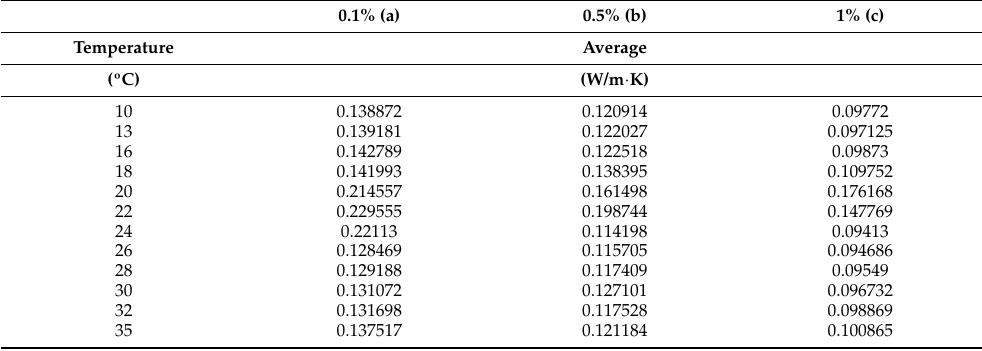
Figure 4. Coefficient of thermal conductivity depending on the proportion of polymer (a) 0.1%, (b) 0.5% and (c) 1%. Table 5. Results of the thermal conductivity coefficient for individual samples of gypsum composite depending on the polymer content.